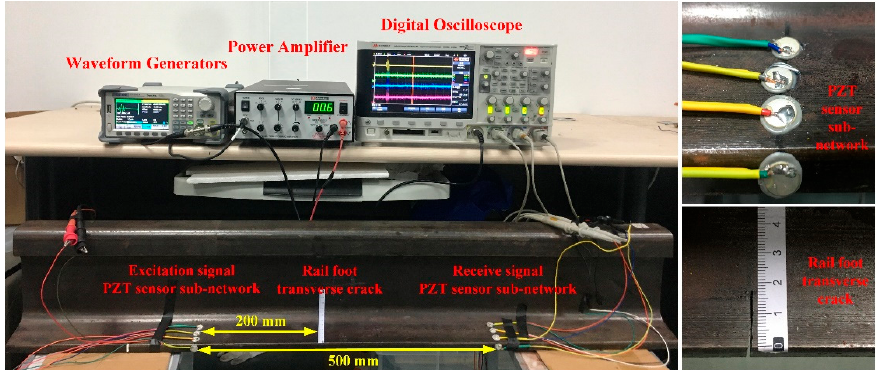
Figure 16. Diagram of the actual experimental system.